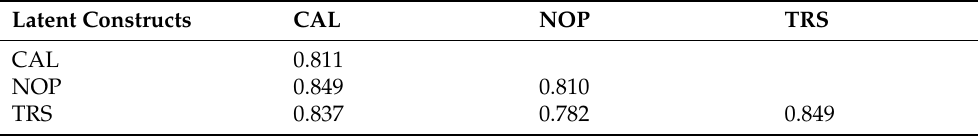
Table 4. Discriminant validity.